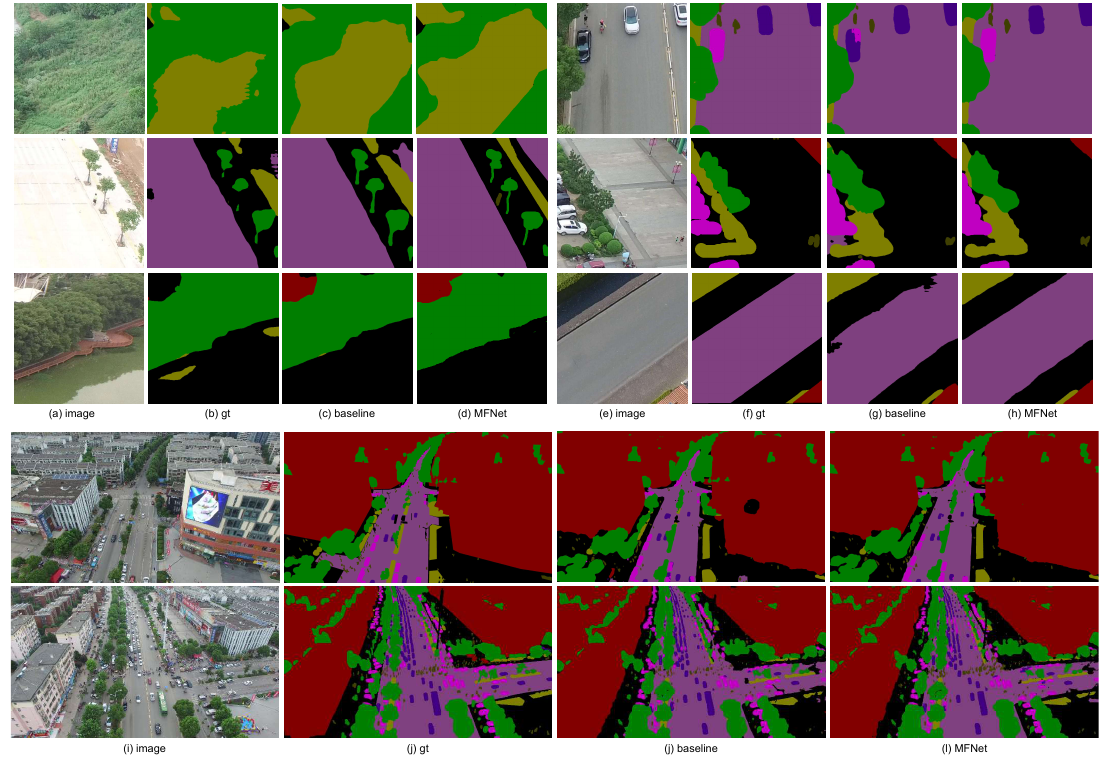
Figure 10. Visualization of the results of the UAVid dataset. Notably, the baseline is FCN. Table 13. Comparisons with state-of-the-art on UAVid test set.